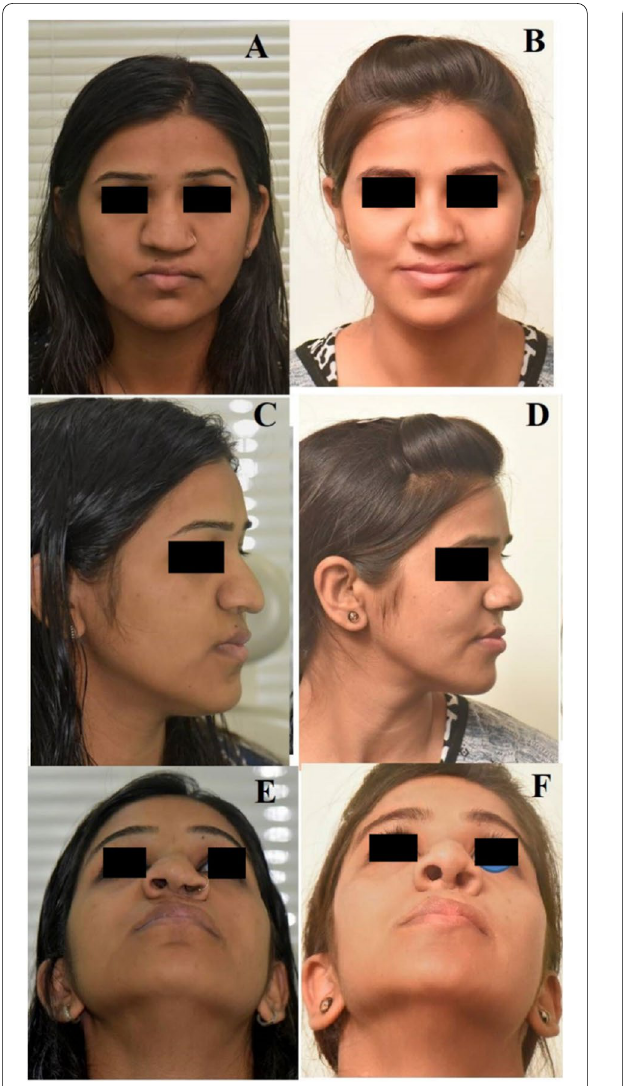
Fig. 6 Comparative pre- and post-operative pictures at 2 years follow-up. A Pre-operative frontal view. B Postoperative frontal view. C Pre-operative left lateral view. D Post-operative left lateral view. E Pre-operative basal view. F Postoperative basal view